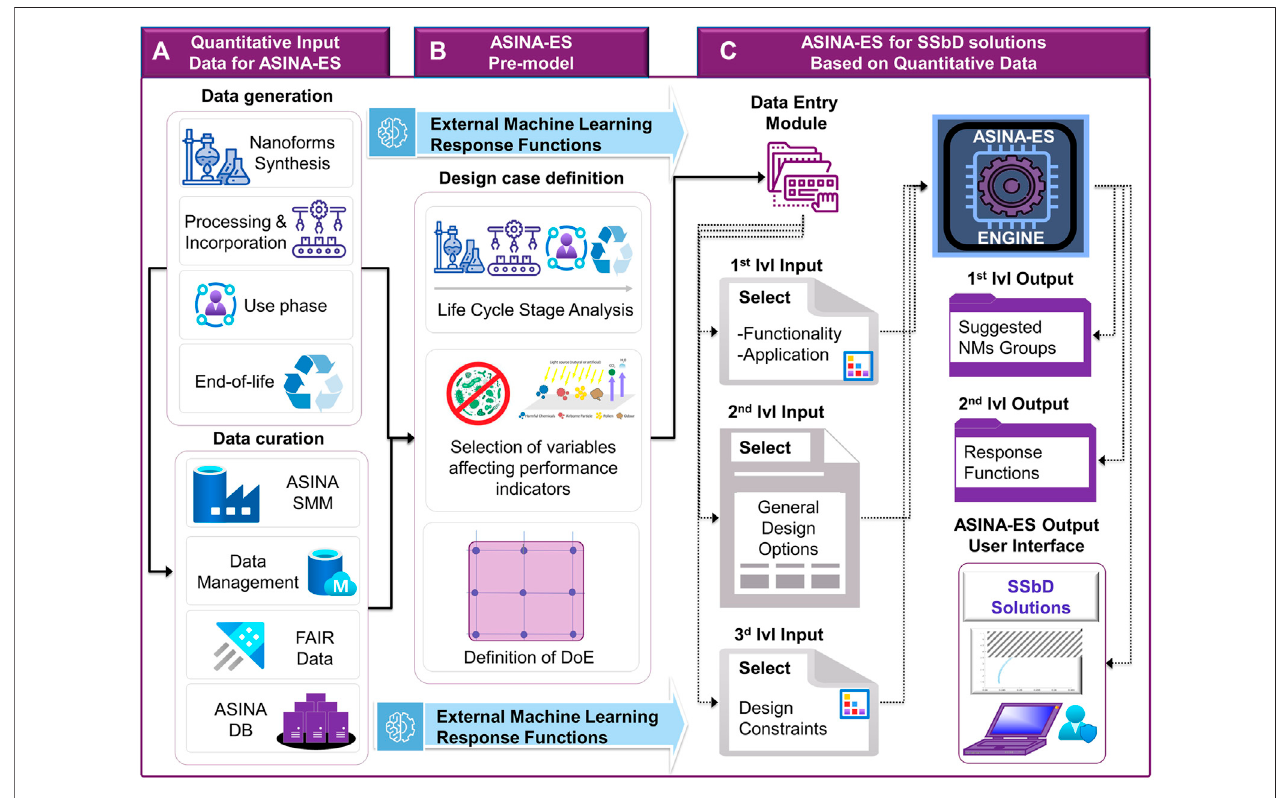
FIGURE 2 | ASINA-ES metamodel elaborating response functions as representation of experimental or computed performances for the selection of SSbD solutions.